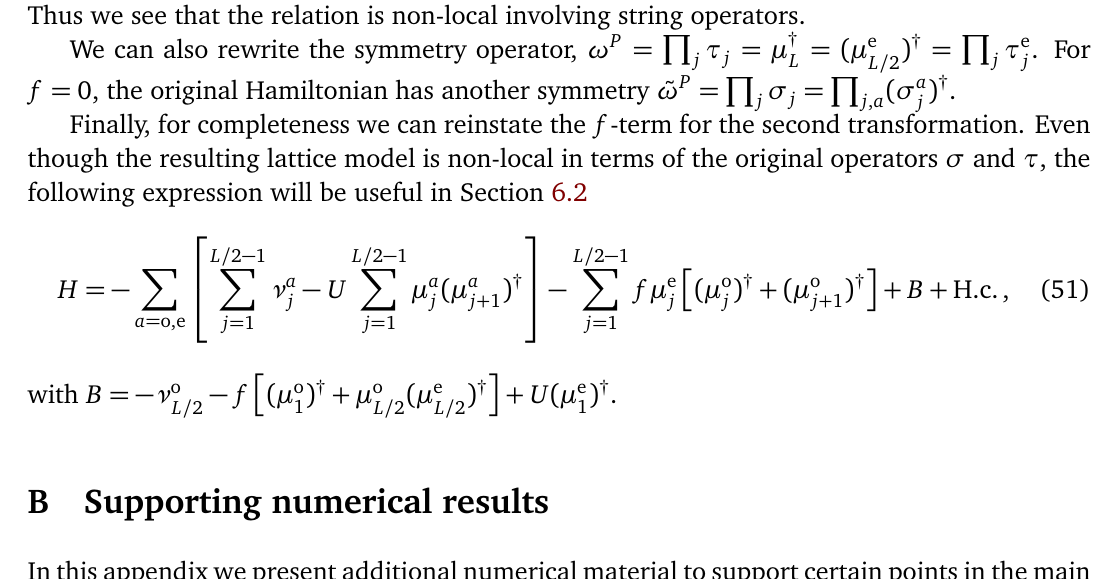
Figure 12: Rough topography of the phase diagram for the (cid:90) central-cut entanglement entropy and central charge results were obtained for small system sizes L = 50–100 and low bond dimension in the parity sector 0. Even though the nature of the phases and transitions cannot be conclusively derived from these plots, it gives a good visual guide for the features to be studied in more